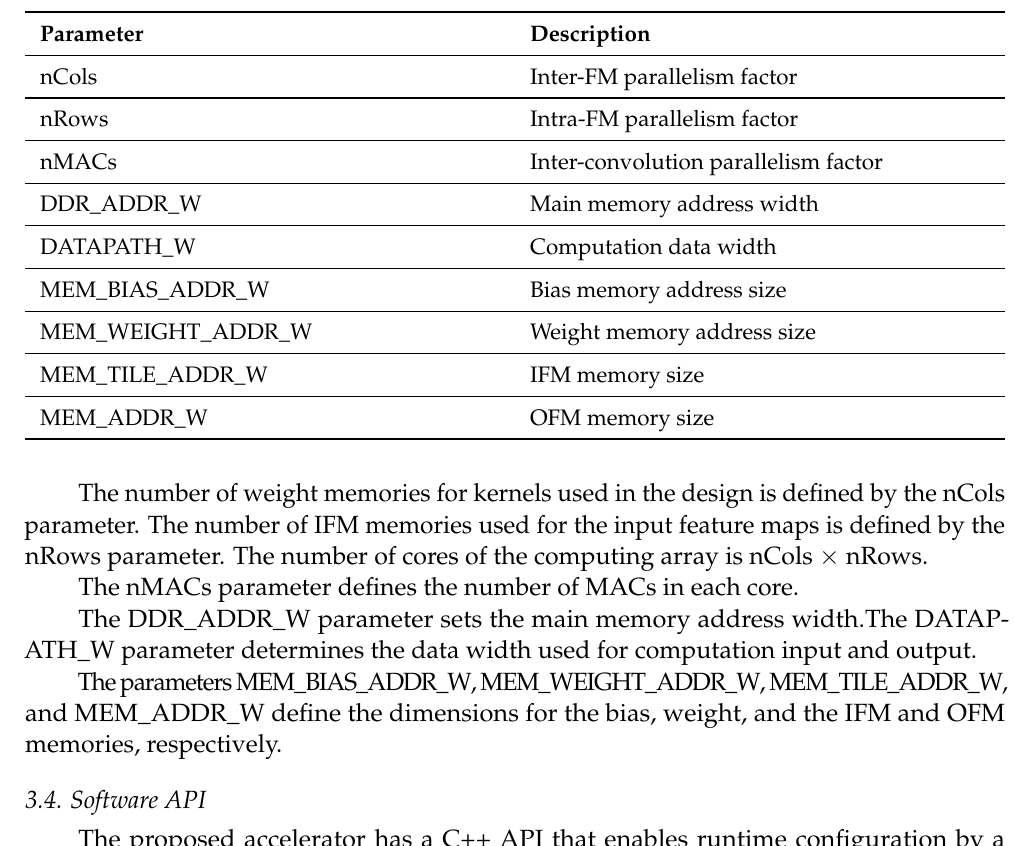
Table 4. Configuration parameters of the object detector